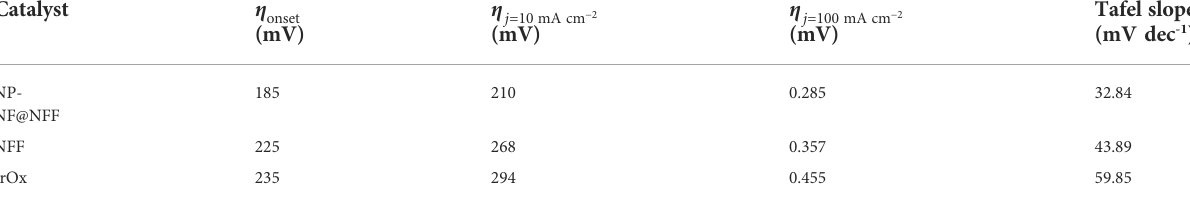
TABLE 1 Comparison of catalyst activity in the OER.